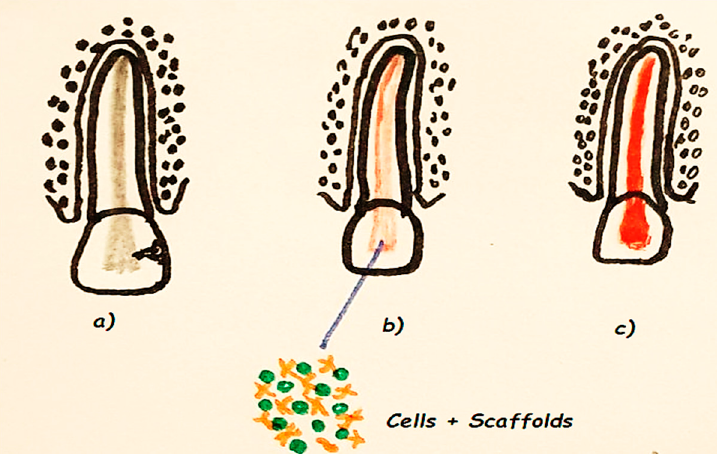
Figure 3. Regeneration of functional pulpal tissue: ( a ) non-vital pulp, ( b ) transplantation of stem cells, ( c ) regenerated pulp.